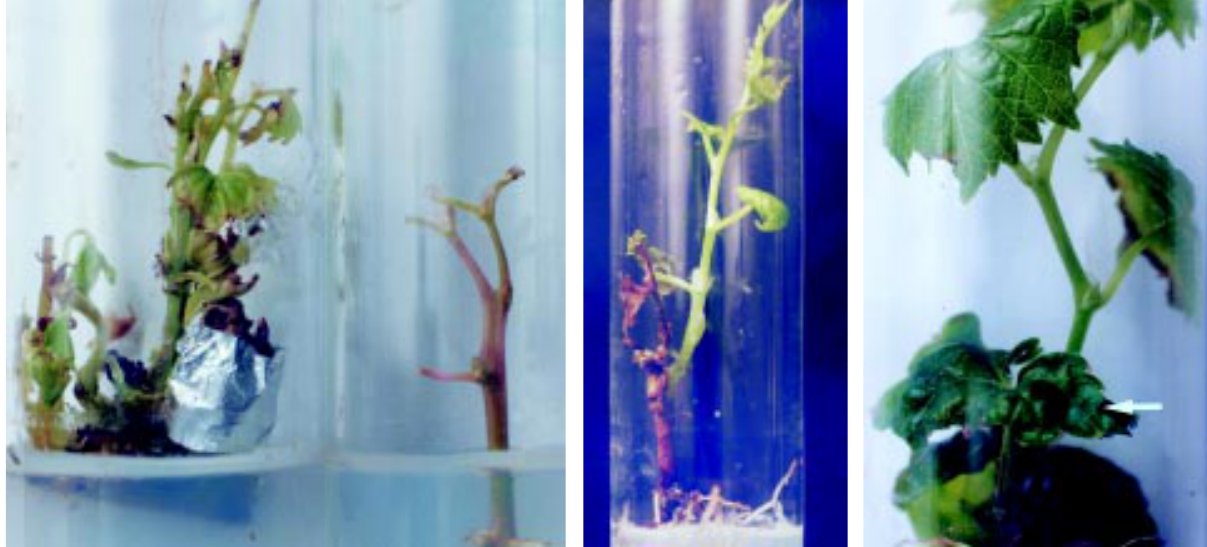
Fig. 7. Asymmetry and basal leaf Fig. 6. Outward bark atrophy exhibited on Cabernet browning and blacken- Sauvignon shoots as symptoms of ing of Kober 55 as symp- infectious degeneration. toms of corky bark.